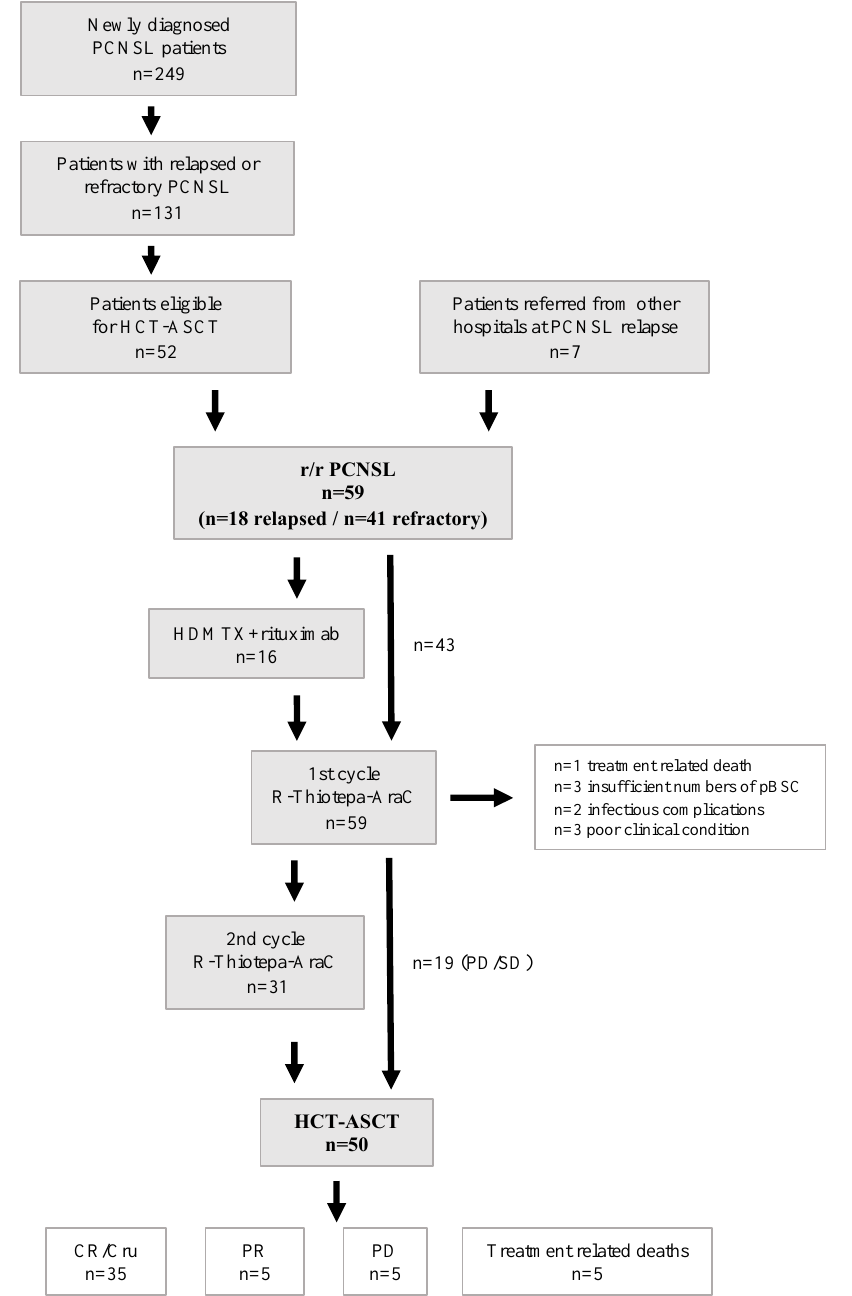
Figure 1. Flow chart of treatments and responses of patients with r/r PCSNL. Abbreviations: CR/Cru— complete remission/complete remission unconfirmed, HCT-ASCT—high dose chemotherapy with autologous stem cell transplantation, HDMTX—high dose methotrexate, r/r—relapsed/refractory, PCNSL—primary CNS lymphoma, pBSC—peripheral blood stem cells, R-Thiotepa-AraC—rituximab, thiotepa, cytarabine.